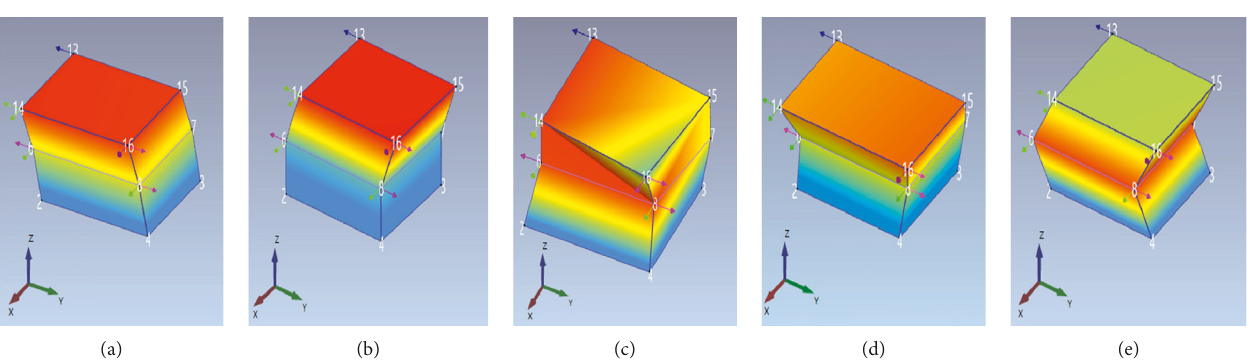
Figure 12: The first five mode shapes of the houses. (a) 1 st mode bending. (b) 2 nd mode bending. (c) 3 rd mode torsion. (d) 4 th mode bending. (e) 5 th mode bending.